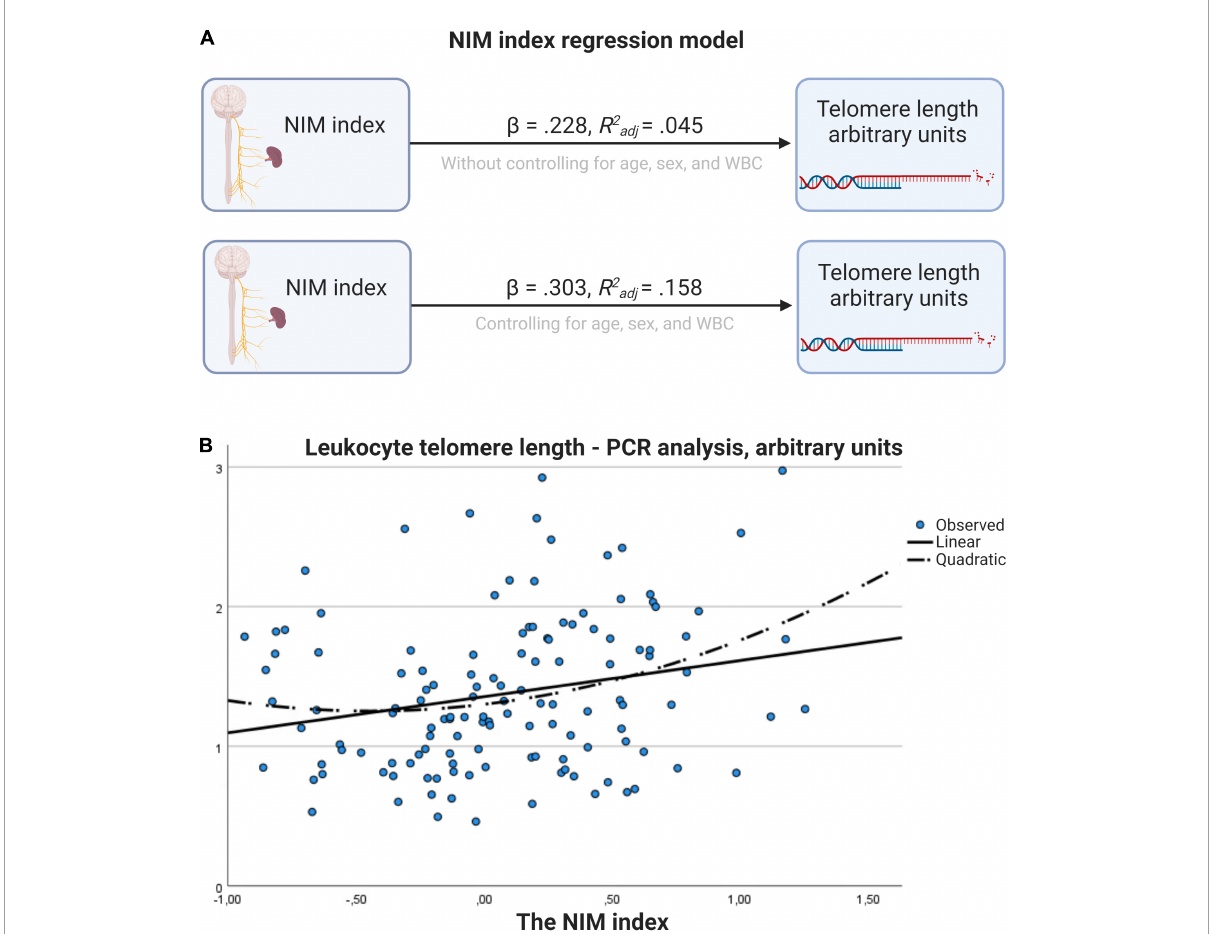
FIGURE3 Regression model for the relationship between NIM index and telomere length. (A) Results with and without controlling for age, sex, and WBC. (B) Scatter plot with linear and quadratic regression line. Figure created with